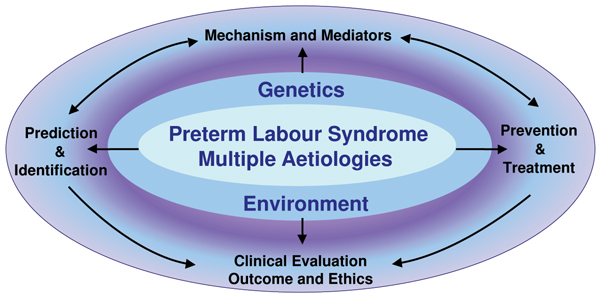
Preterm labour is a complex syndrome of multiple aetiologies requiring a multidisciplinary research approach.